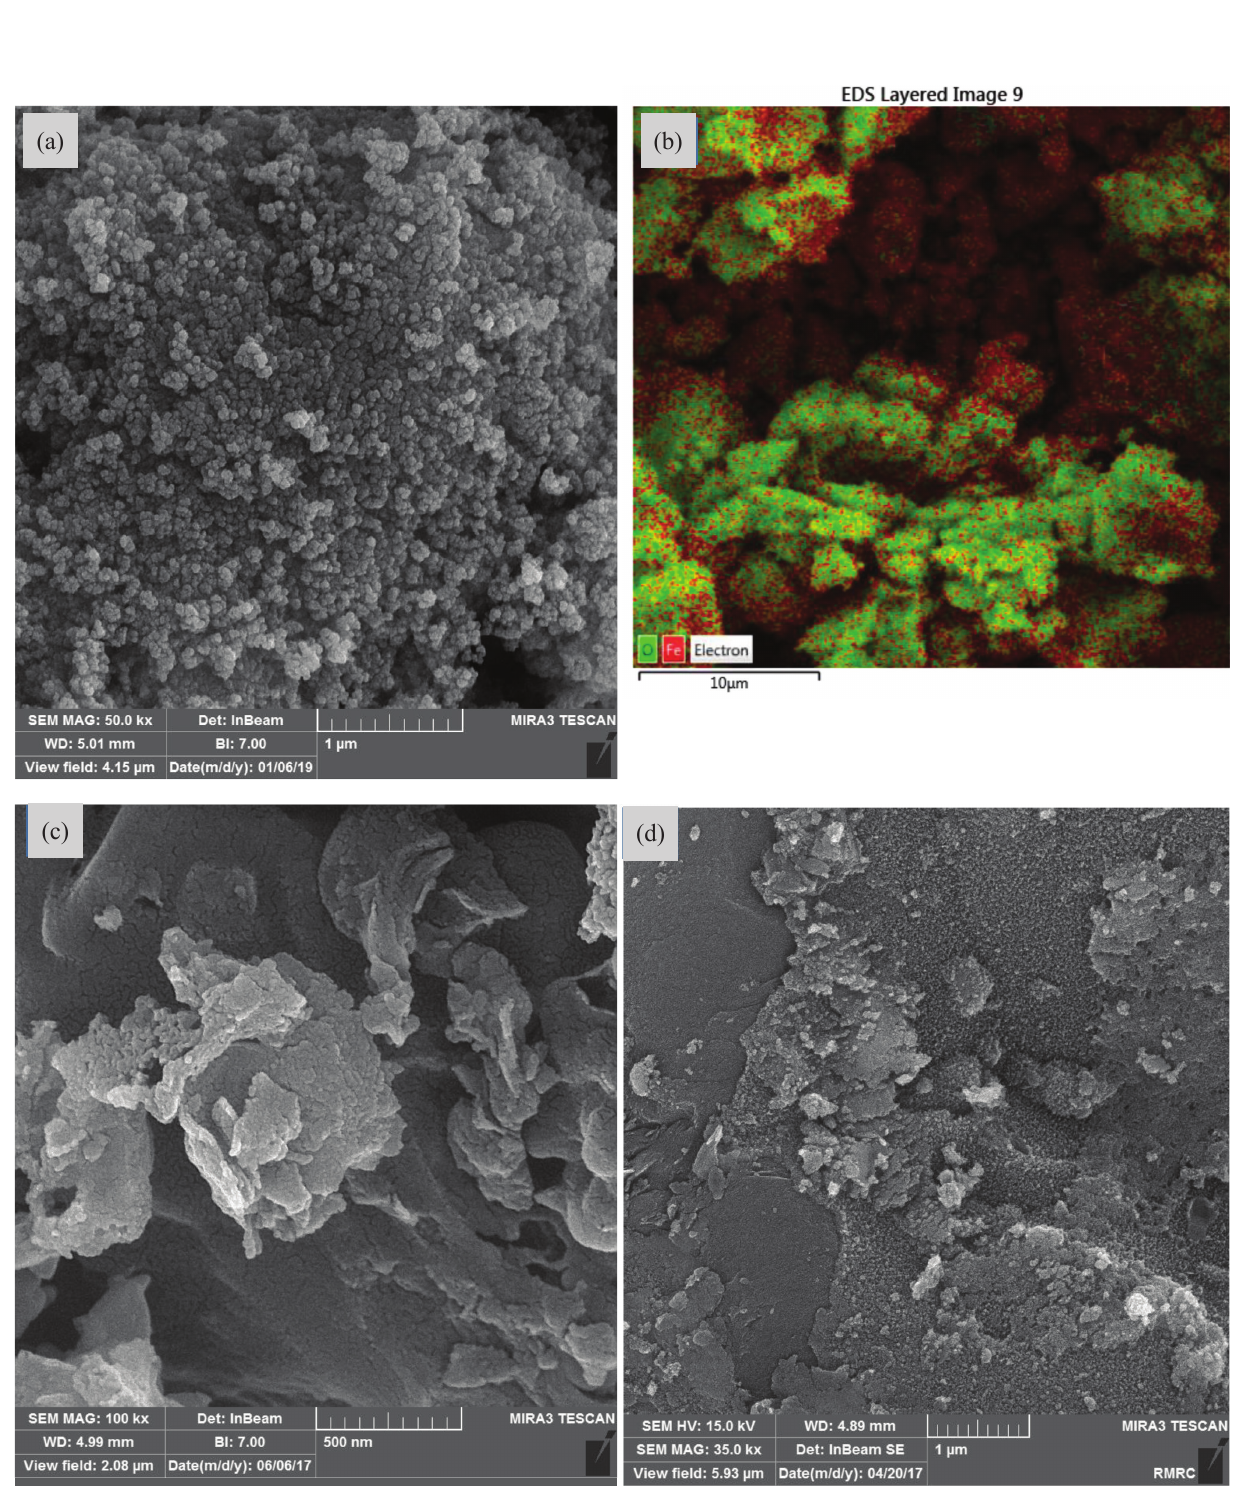
Fig. 2 – Fe-SEM images of synthetized composite (a) Fe support, and (d) Fe@C